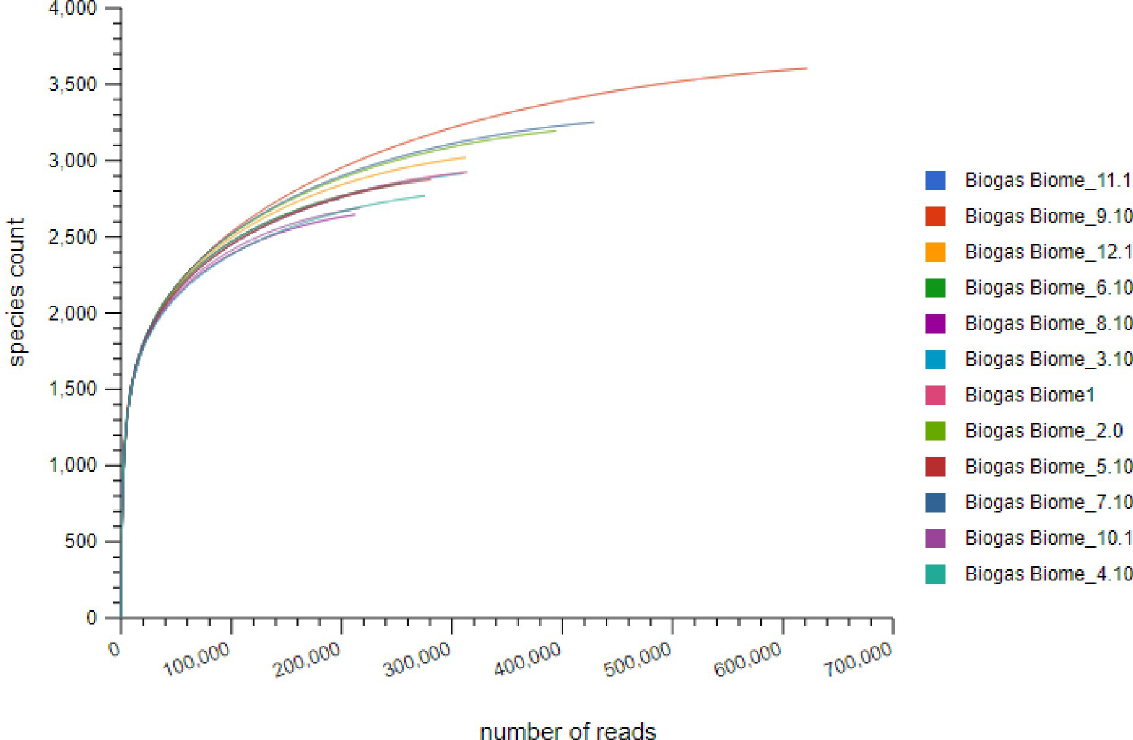
Fig 4. Rarefaction plot showing a curve of annotated species richness. The curve is a plot of the total number of distinct species annotations as a function of the number of sequences sampled.